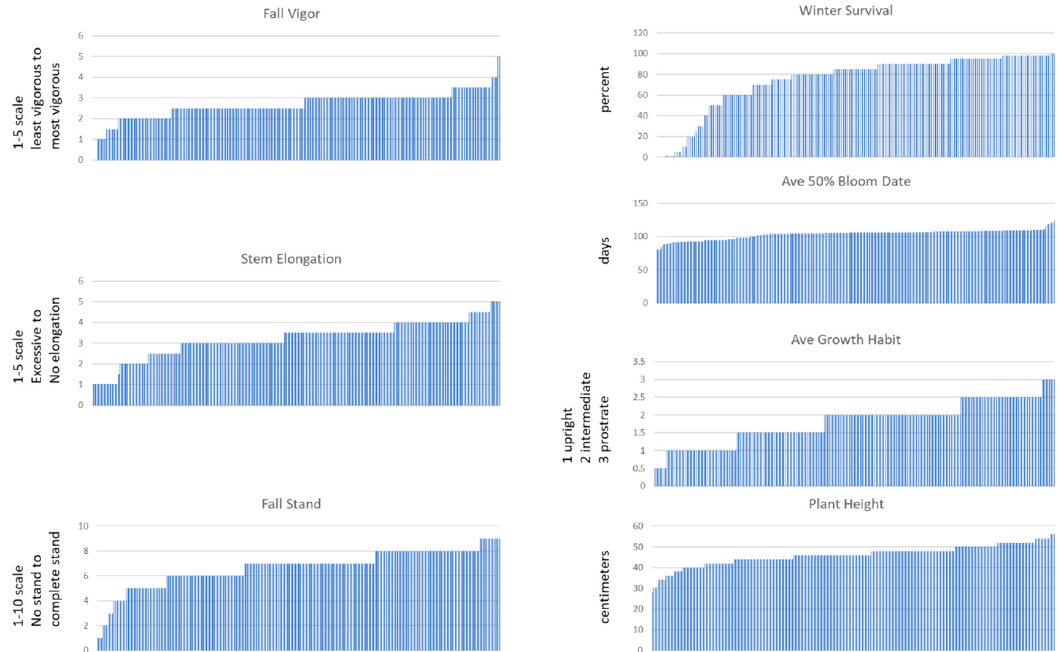
Figure 6. Phenotypic variations for several agronomic traits of interest within the diversity panel. Fall vigor, stem elongation, and fall stand were evaluated on a 1:5, 1:5, and 1:10 visual scale, respectively. Winter survival was an estimate percentage, average 50% bloom date was the average days to 50% flowering for 2016 and 2018, average growth habit was scored as 1 = upright, 2 = intermediate, and 3 = prostrate, plant height was the height of the topmost flowers in inches.